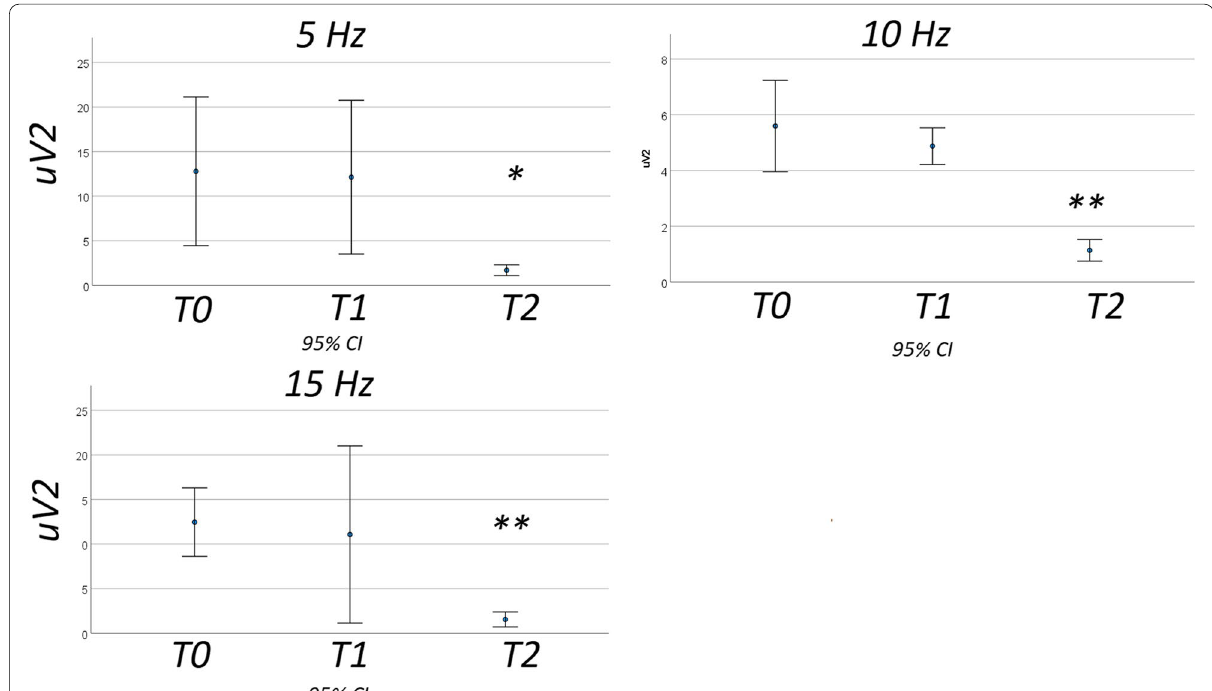
Fig. 5 Mean and 95% CI of spectral power of F (5 Hz),2F (10 Hz) and 3F (15 Hz) elicited with 5 Hz stimulation in 13 migraine patients in basal condition (T0), after 1 h galcanezumab (T1) and 3 months galcanezumab (T2). Results of Bonferroni test are shown: T2 vs T0 and T1 * p < 0.05; ** p < 0.01; T2 vs T0 p < 0.01 ++